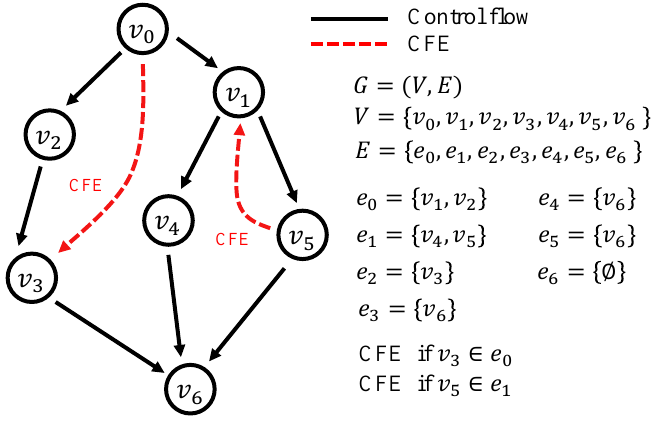
Figure 1. Control flow and